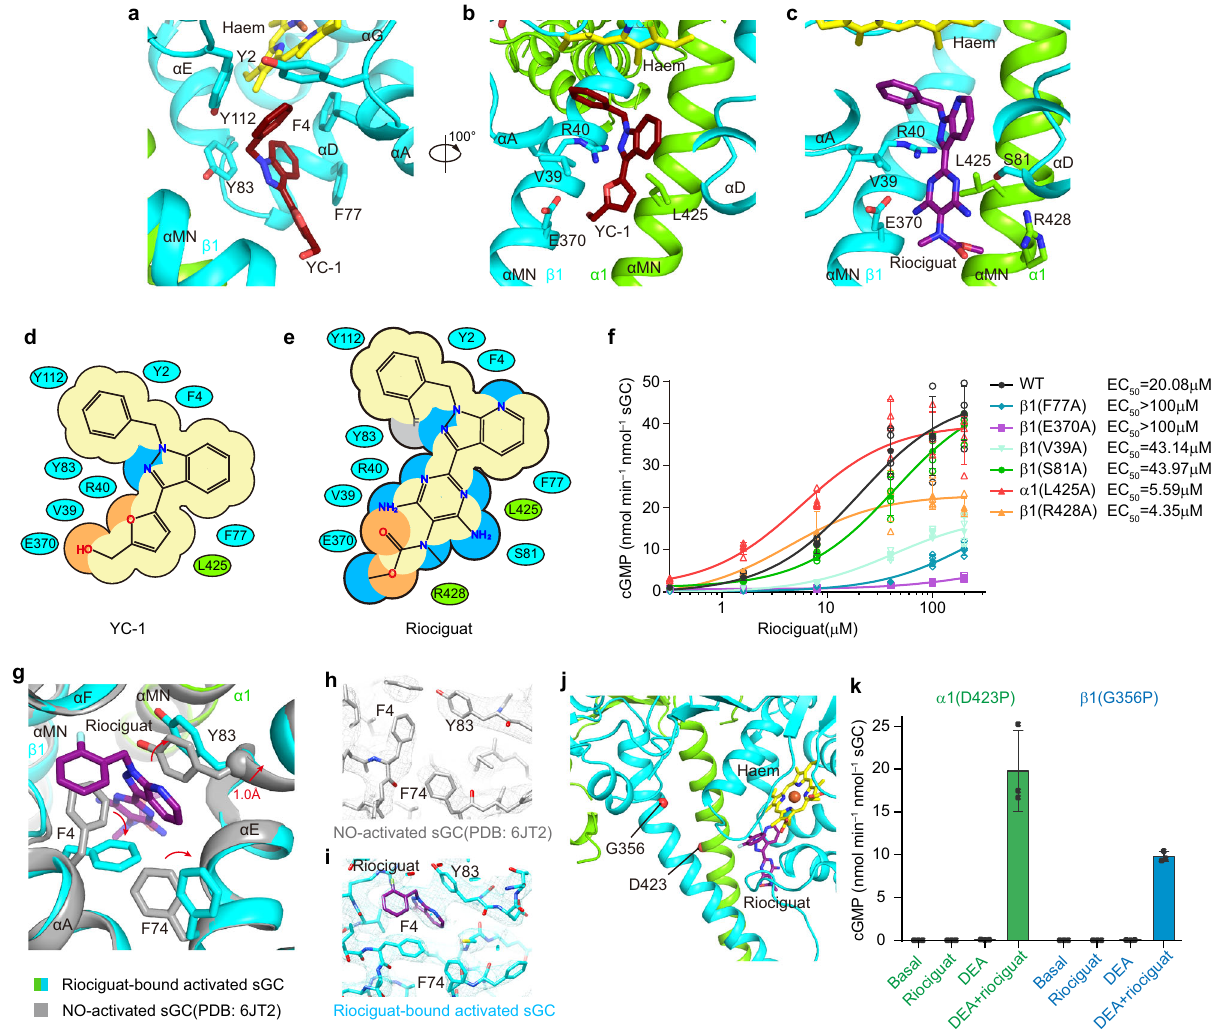
Fig. 2 Binding site of sGC stimulators. a The interactions between YC-1 and sGC. Protein is colored the same as in Fig. 1. b A 100° rotated view compared to ( a ). c The interactions between riociguat and sGC in the same view as in ( b ). d Cartoon representation of interactions between YC-1 and sGC. Residues from the α 1 and β 1 subunits are shown as green and cyan, respectively. e Cartoon representation of interactions between riociguat and sGC. Residues are colored the same as in ( d ). f Dose-dependent activation curve of wild type and alanine mutants of sGC in the presence of 1 mM BIC and riociguat at different concentrations ranged from 0.32 mM to 200 mM. Mean± s.d., n = 3 or 4 independent reactions. Source data are provided as a Source Data fi le. g Structure comparison between NO- and riociguat- bound states (colored) and the NO-activated state (gray) at the stimulator-binding site. The conformational changes induced by riociguat binding are indicated by red arrows. h – i Cryo-EM density maps around the sGC stimulators binding site in the NO-activated state ( h ) and NO- and riociguat- bound state ( i ). The residues undergo conformational changes in the two states shown in ( g ) are labeled. j Locations of the α 1 D423 and β 1 G356 residues in the NO- and riociguat- bound state. The aC atoms of α 1 D423 and β 1 G356 are shown as red spheres. k End-point activity assay of sGC proline mutations in the absence or presence of 100 mM DEA or 200 mM riociguat. Mean ± s.d., n = 3 independent reactions. Source data are provided as a Source Data fi